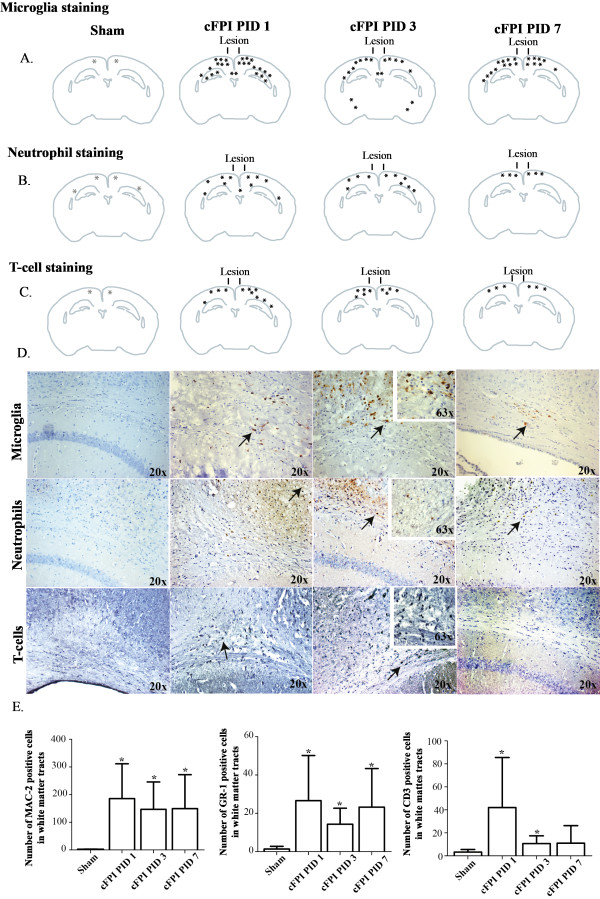
Overview of the distribution of microglial, neutrophil and T-cell staining at 1, 3 and 7 days after cFPI or sham-injury in mice.(A-C) The microglial staining was increased throughout the observation period in the cortex and in the subcortical white matter, especially at one day post-injury. Infiltrating neutrophils appeared at one day post-injury in the cortex and subcortical white matter. T-cells were observed in the cortex and in the subcortical white matter after one day post-injury but then the number of cells declined; (D) The inflammatory response after cFPI or sham-injury. The images show activated microglia/macrophages (MAC-2), neutrophils (GR-1) and T-cells (CD3) in the external capsule from post-injury day (PID) 1 to 7, examples of cells staining positive for the cell type marker are indicated with arrows. Inserts show the same area in the external capsule at a higher magnification; (E) Cell counts of microglia/macrophages, neutrophils and T-cells in the corpus callosum, external capsule and fimbria of hippocampus from 1, 3 and 7 days post-injury (presented as means ± SD). *Indicates a statistically significant difference compared to sham-injured controls (P<0.05).